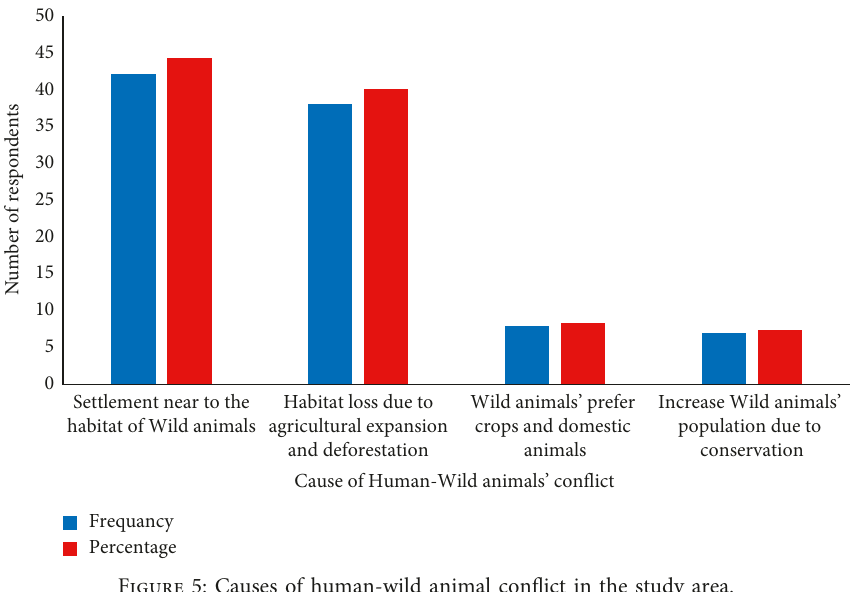
Figure 5: Causes of human-wild animal conflict in the study